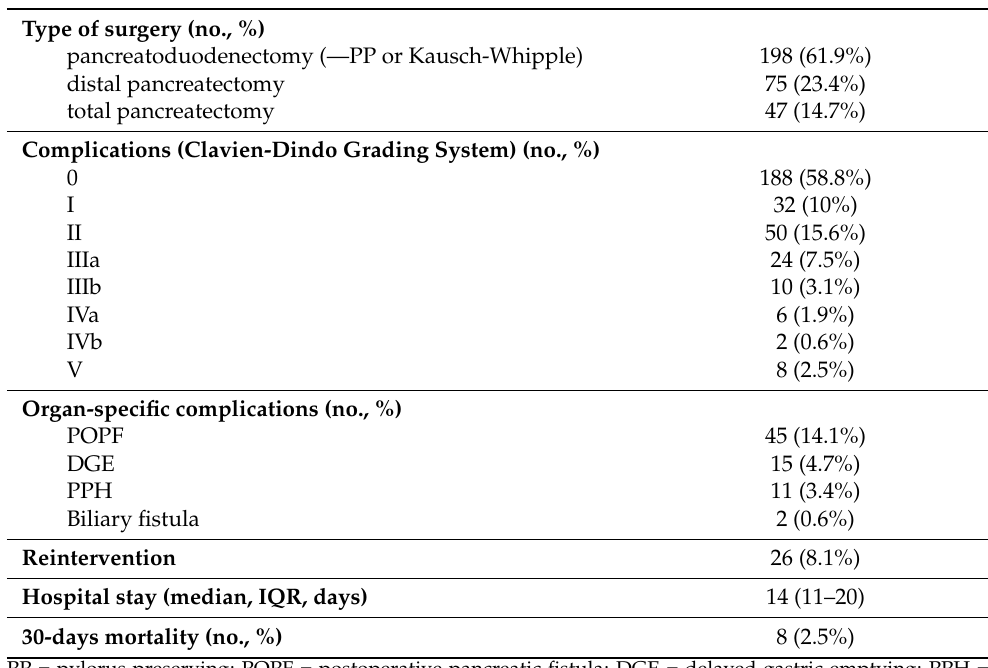
Table 2. Surgery ( n = 320).